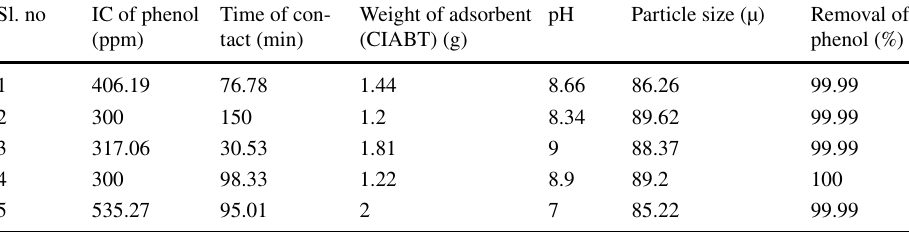
responses and corresponding operating parameters obtained by particle swarm optimization (PSO) for removal of